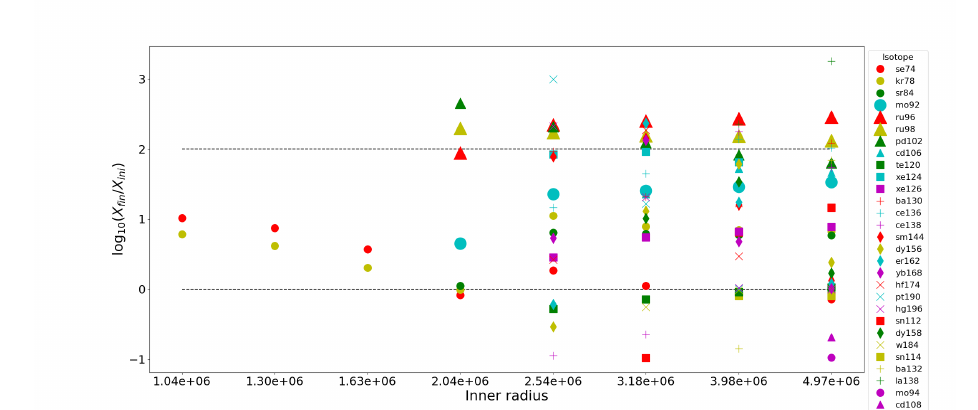
Figure 3. E ff ect of changing the inner radius on production of p-nuclides for a set of trajectories modelling accretion around a 1 . 5M ⊙ neutron star at an accretion rate of 8 × 10 − 5 M ⊙ s − 1 . Any isotopes which had an overproduction of less than − 1 were not included.